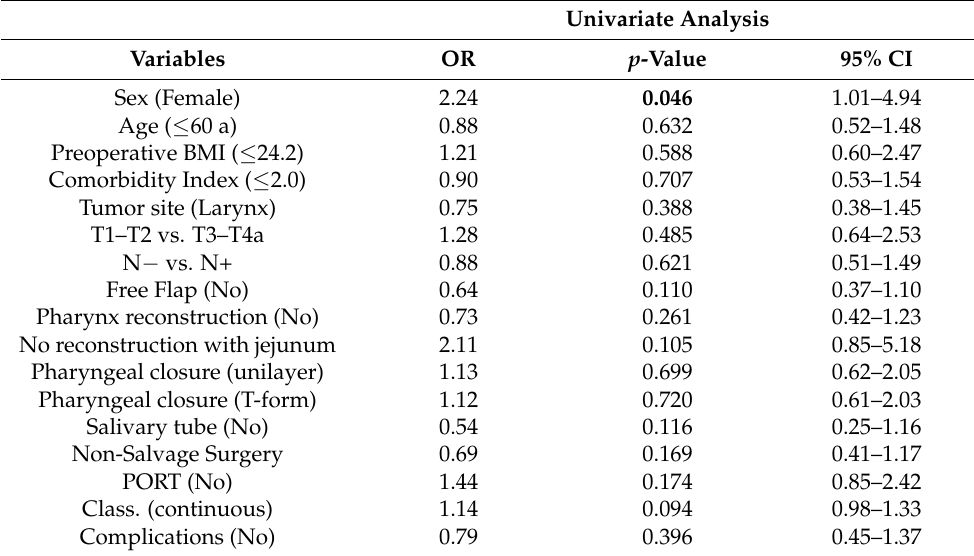
Table 3. Pharyngocutaneous fistula.